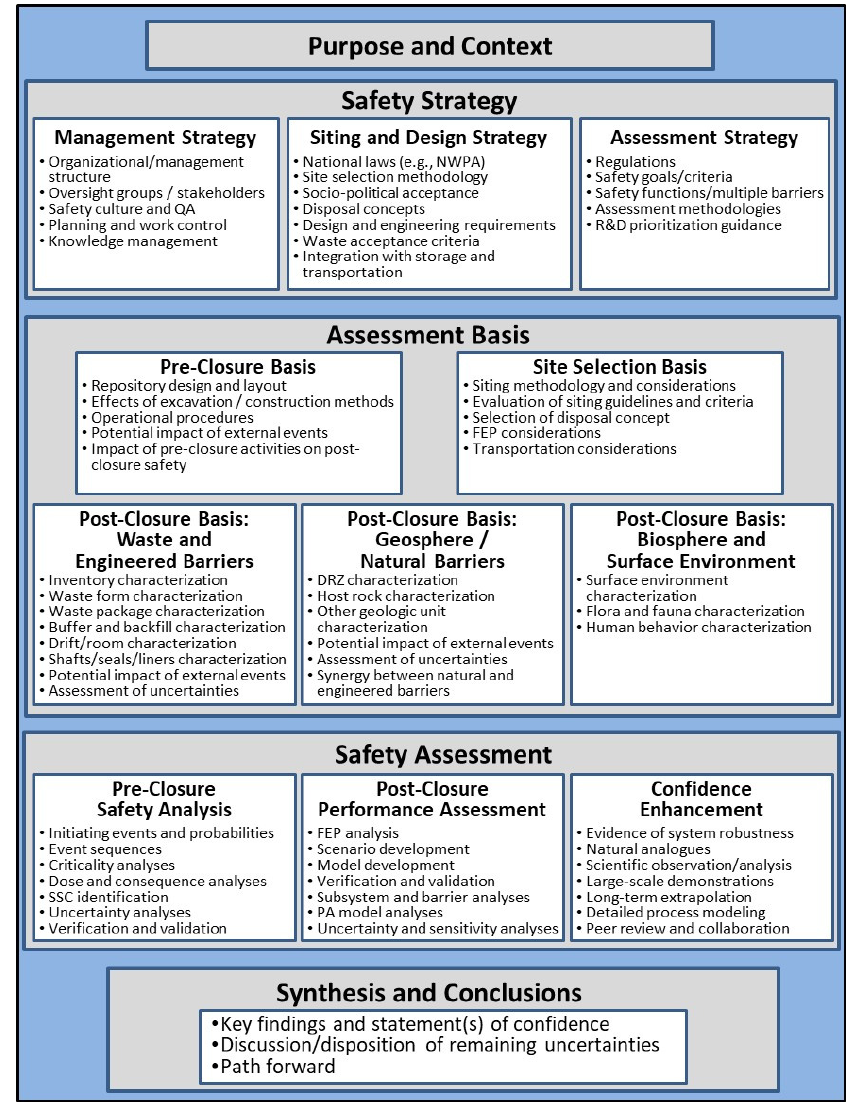
Figure 1. Key Elements of a Safety Case (QA = Quality Assurance; NWPA = Nuclear Waste Policy Act; FEP = feature, event, and process; DRZ = Disturbed Rock Zone). Source: Freeze et al.